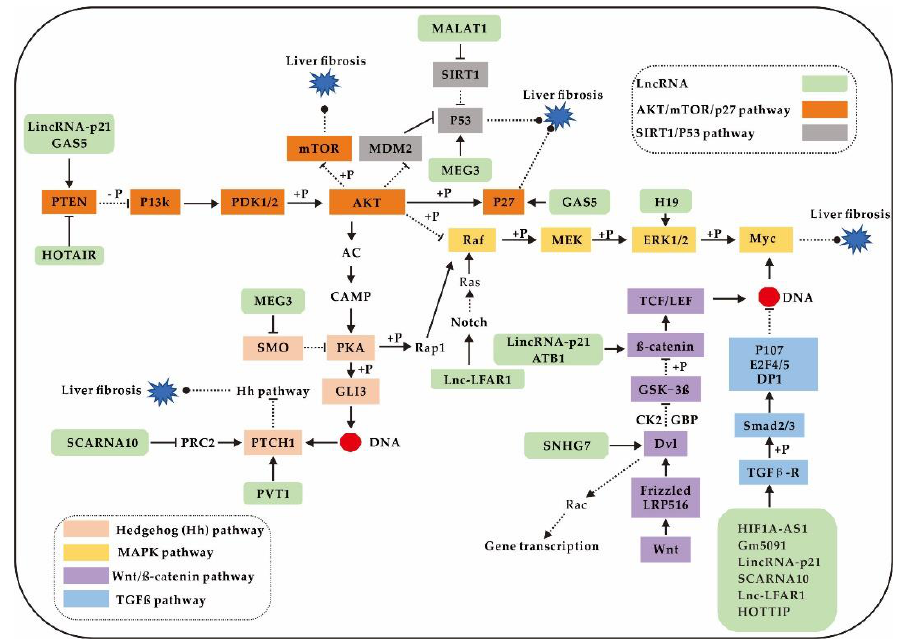
Figure 3. LncRNAs are involved in the regulation of liver fibrosis by multiple signalling pathways.